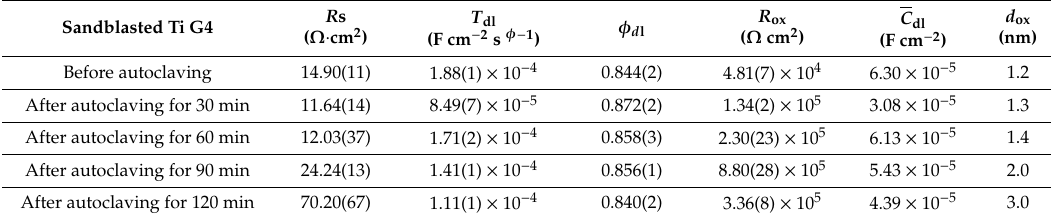
Table 9. The value of parameters with their standard deviations obtained using the equivalent electrical circuit model for corrosion shown in Figure 11c to approximate the experimental EIS data for the sandblasted Ti G4 electrode before and after autoclaving in ASS at 37 ◦